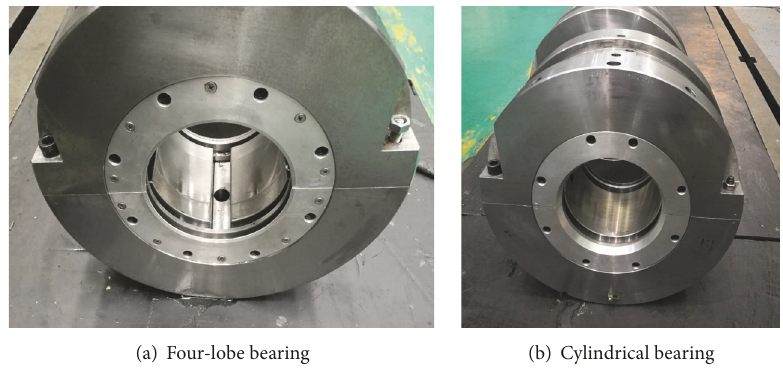
Figure 7: Two types of bearings.